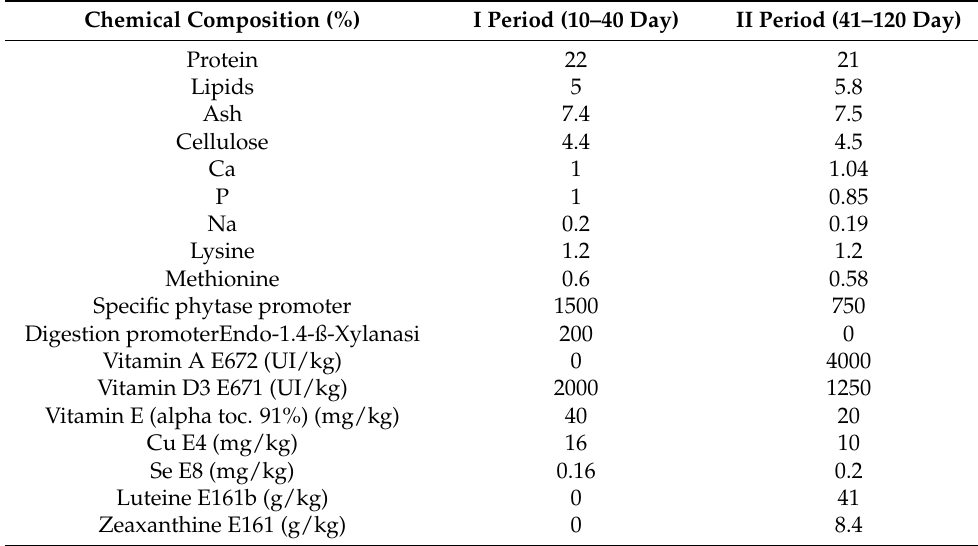
Table 1. Chemical composition of the two feeds used during the grow-out cycle in the two groups (C, P) of guinea